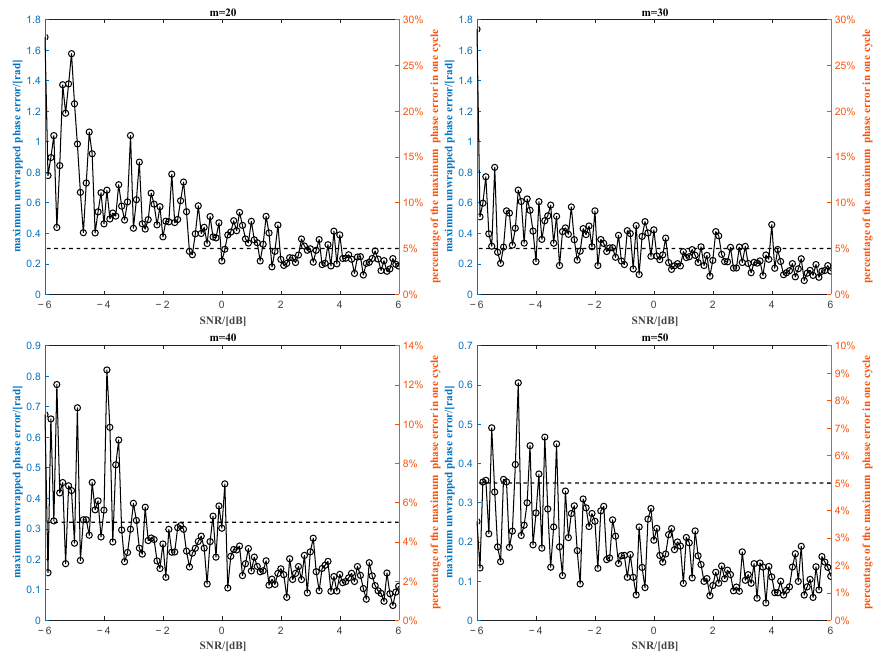
Figure 10. The maximum phase error of different SNRs for different number of rows of the Figure10. Themaximumphaseerrorofdi ff erentSNRsfordi ff Hankel matrix.